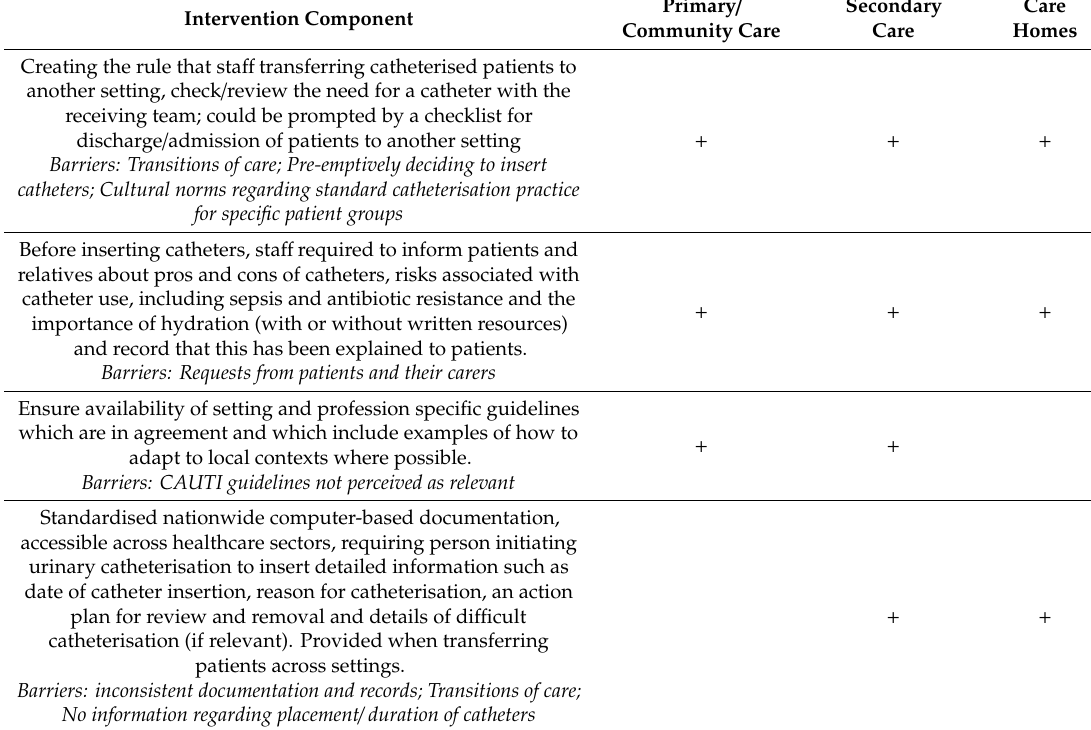
Table 3. Overview of prioritised intervention components and the addressed